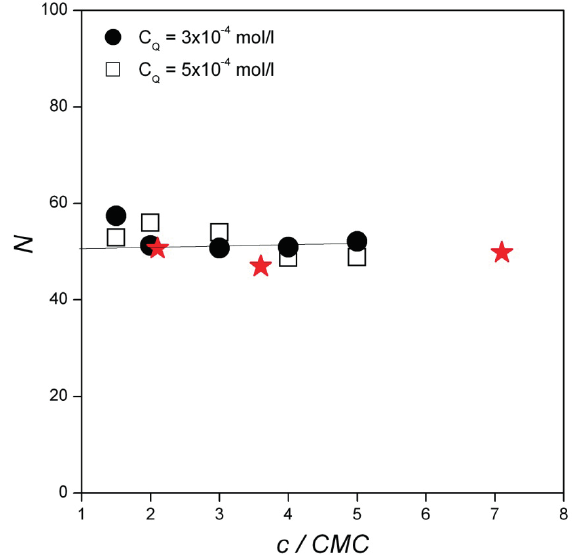
Figure 2: CTAB concentration dependence of aggregation number N for three emission wavelengths and the quencher concentration 8.1 × 10 -4 mol L -1 . The star symbol denotes the published aggregation number value taken from [27].